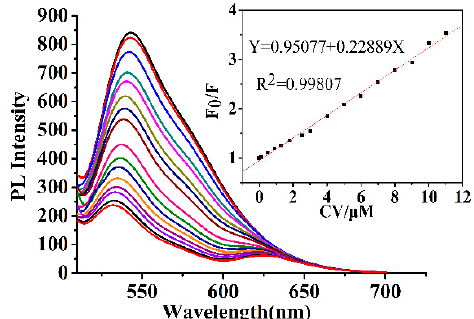
Figure 8. Emission spectra of Y-CDs after the addition of Crystal violet (from top to bottom: [Crystal violet] = 0, 0.1, 0.5, 0.9, 1.3, 1.8, 2.5, 3.0, 4.0, 5.0, 6.0, 7.0, 8.0, 9.0, 10.0, and 11.0 µ M). Inset: The standard curve of the relationship between F 0 /F.